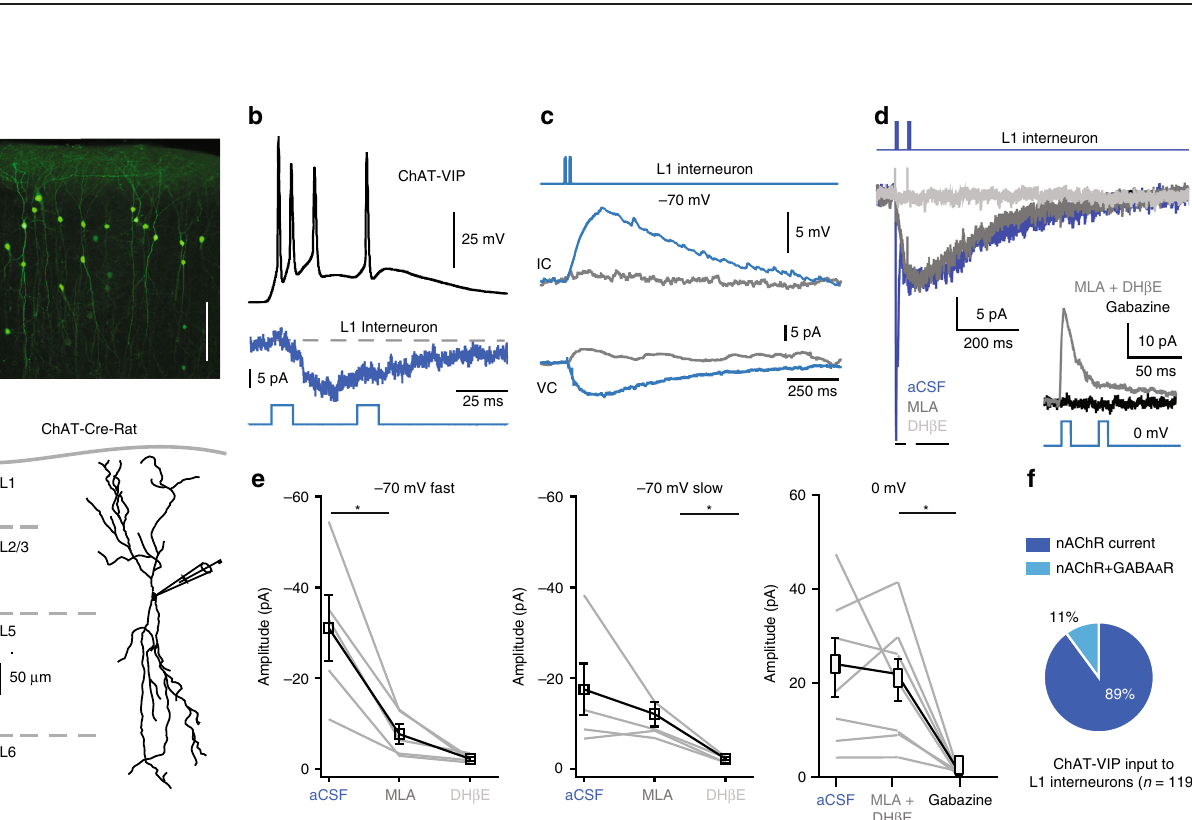
Fig. 1 Fast cholinergic synaptic transmission by ChAT-VIP cells. a EYFP-labelled ChAT-VIP interneuron targeted for recording in an acute mouse mPFC brain slice (DIC-IR microscope). Scale bar 100 μ m. b Schematic of simultaneous recordings of presynaptic ChAT-VIP interneurons and postsynaptic L1 interneurons. c Membrane potential responses of a L1 interneuron (top) and L2/3 ChAT-VIP interneuron (bottom) to depolarizing ( + 200 pA) and hyperpolarizing ( − 150 pA) somatic current injection. d Example traces of a synaptically-connected ChAT-VIP cell and a L1 interneuron. Top trace: short step depolarization. Second trace: Presynaptic AP in ChAT-VIP interneuron. Third trace: fast postsynaptic inward current of the L1 interneuron (black trace, average of 45 sweeps), blocked by nAChR antagonists (MLA 100 nM, grey trace). Fourth trace: short step depolarization. Fifth trace: Presynaptic AP in ChAT-VIP interneuron. Bottom trace: slow postsynaptic inward current of the L1 interneuron (black trace, average of 57 sweeps), blocked by nAChR antagonists (DHßE 10 µ M, grey trace). e Histogram of onset delays of postsynaptic currents relative to the peak amplitude of the electrical stimulation- induced presynaptic AP (from n = 11 connected cell pairs). f Amplitudes of successive unitary synaptic currents in the same ChAT-VIP L1-interneuron cell pair as in ( d ). g Recordings from the same neuron pair as in ( d ), but now AP fi ring was induced by activating ChR2 with a blue-light fl ash. Traces and graph as in ( c ). Here and in all other fi gures, for all example traces of responses to optogenetic stimulations 20 sweeps were averaged. h Histogram of onset delays of postsynaptic currents relative to the peak amplitude of the ChR2-induced presynaptic AP (from n = 11 connected cell pairs). i Amplitudes of successive unitary synaptic currents in the recording of the same ChAT-VIP L1-interneuron cell pair in ( f ), but with ChR2-induced presynaptic APs. j Summary of postsynaptic current amplitudes. Box plot centre line: median; bounds of box: 25th to 75th percentile; whiskers: min-max data bound. k Summary of failure rates in the same 11 L1 interneurons. l Postsynaptic response incidence in a separate set of 118 L1 interneurons following ChR2-induced